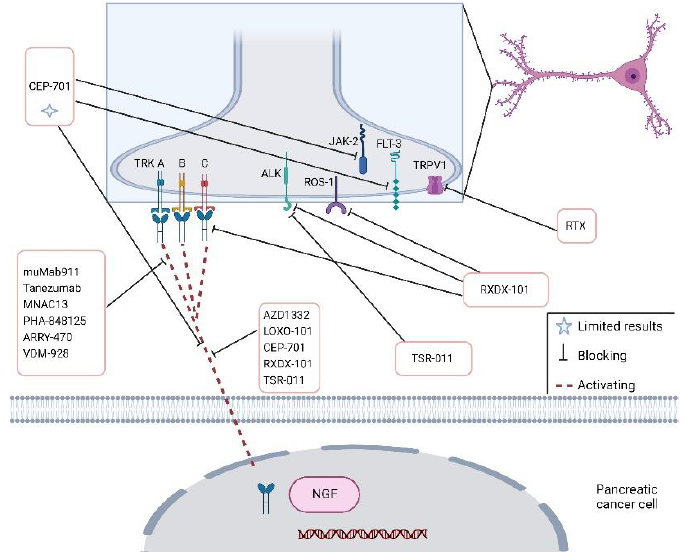
Figure 4. Schematic figure showing therapeutic agents and targets in pancreatic cancer’s perineural invasion. Anaplastic lymphoma kinase (ALK), FMS-like tyrosine kinase 3 (FLT-3), nerve growth factor (NGF), Janus kinase 2 (JAK2), proto-oncogene tyrosine–protein kinase-1 (ROS-1), Resininferatoxin (RTX), tyrosine kinases (TRK), transient receptor potential cation channel subfamily V member 1 (TRPV1). Table 2. Potential therapeutic targets in perineural invasion: conventional and experimental agents. Target Drug Effects